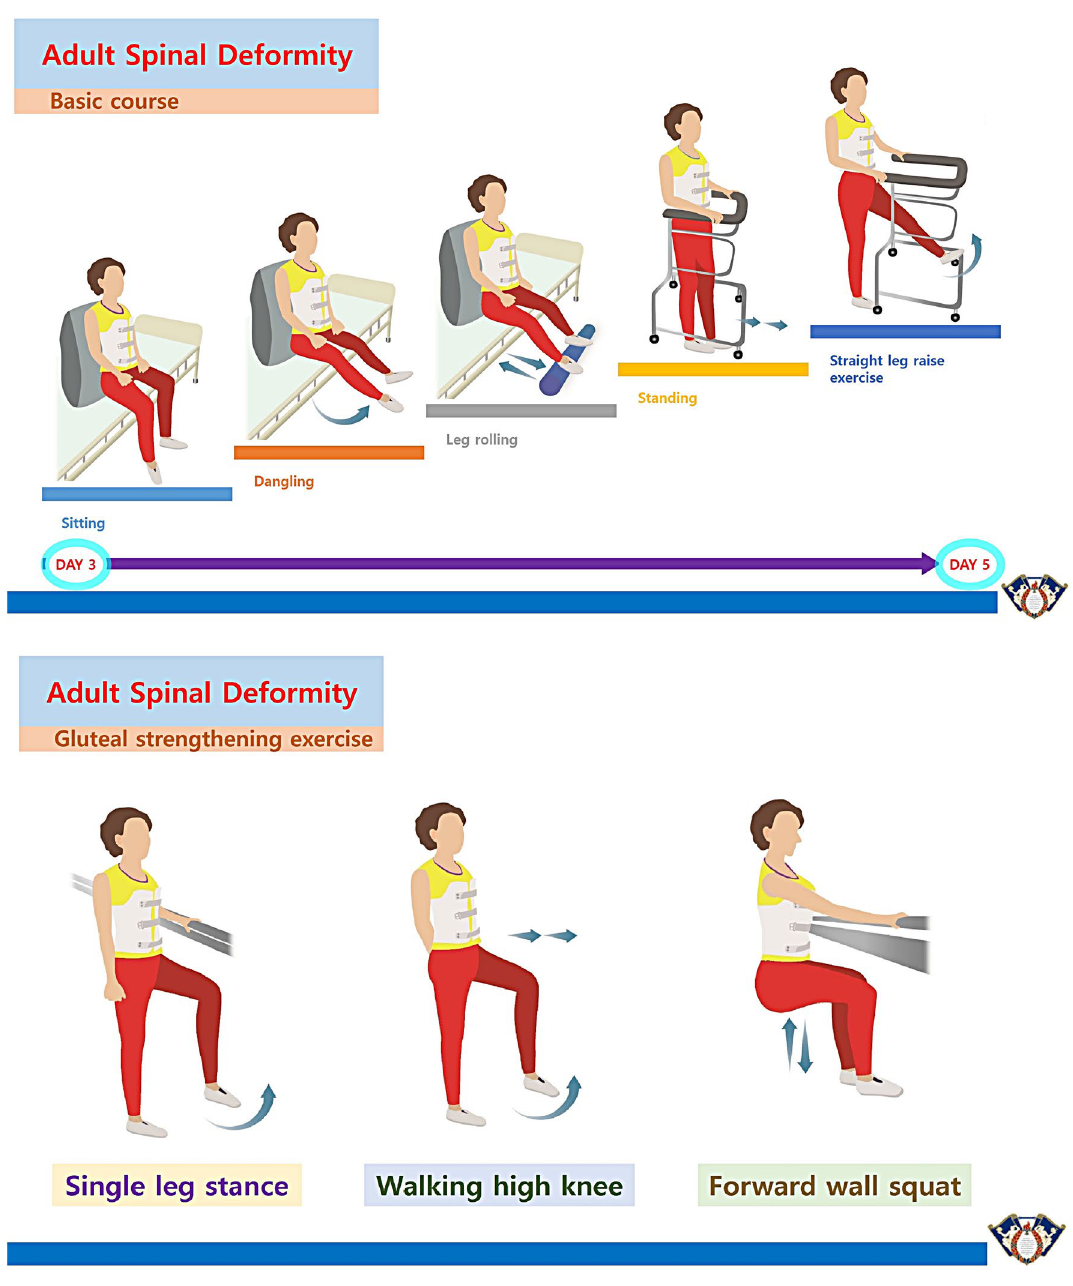
Figure 1. Schematics for our rehabilitation protocol for adult spinal deformity correction. The basic course consists of sitting, dangling, leg rolling exercises with sitting position, standing, and straight leg raising exercises. Gluteal muscle strengthening exercise consists of single leg stance exercise, walking high knee exercise, and forward wall squat